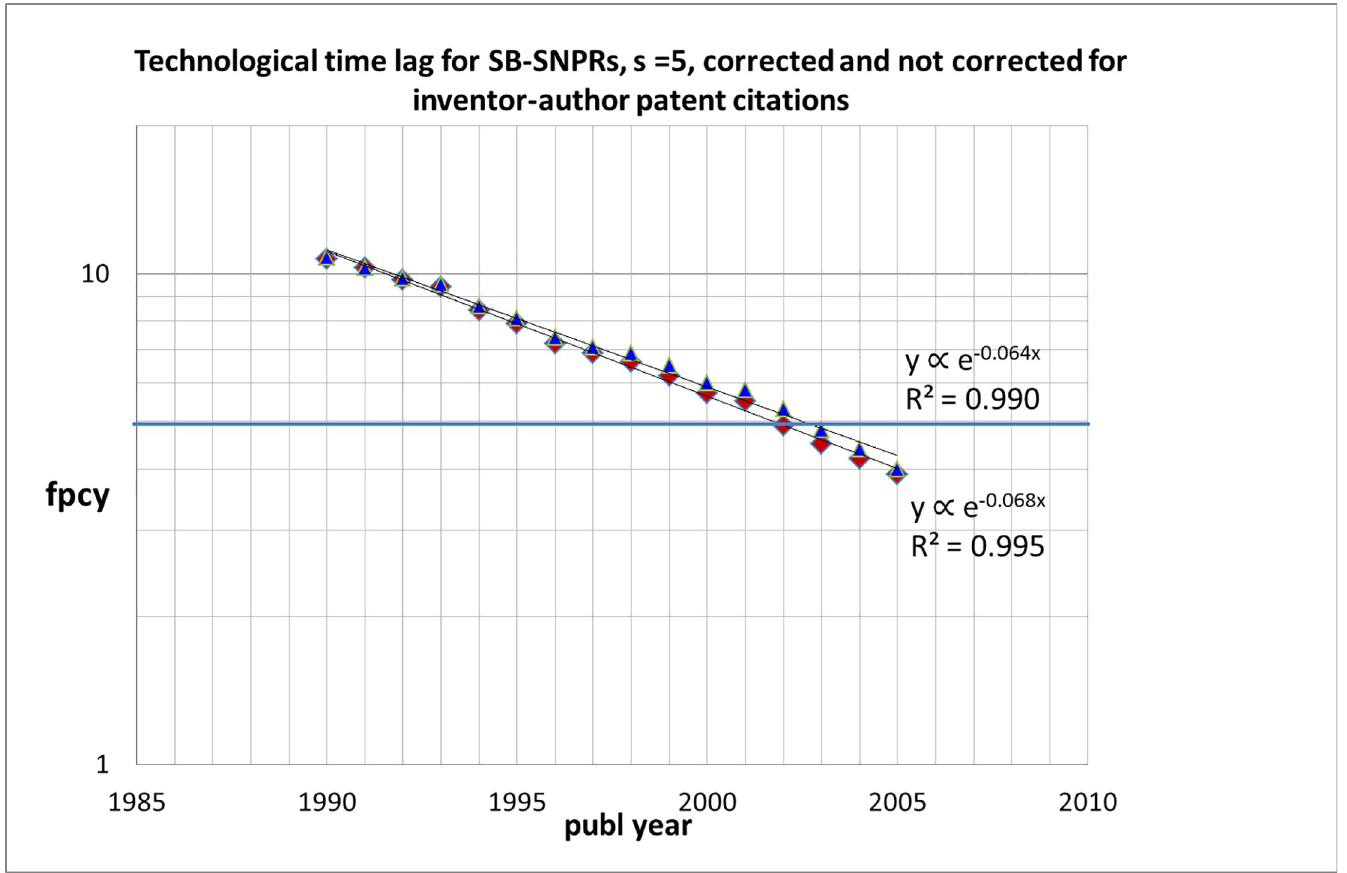
Fig 20. Technological time lag (fpcy) for SB-SNPRs with s = 5 from 1990: corrected (blue triangles) and not-corrected (red diamonds) for inventor-author patent citations. The years indicated on the abscissa are the middle years of the successive 5-years periods. The bold horizontal line indicates a time lag of 5 years which is the sleeping time for the